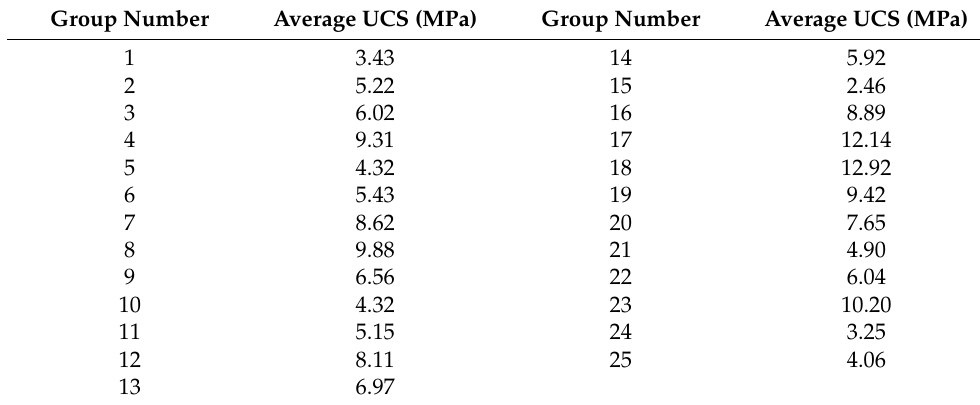
Table 3. The orthogonal experiment results.